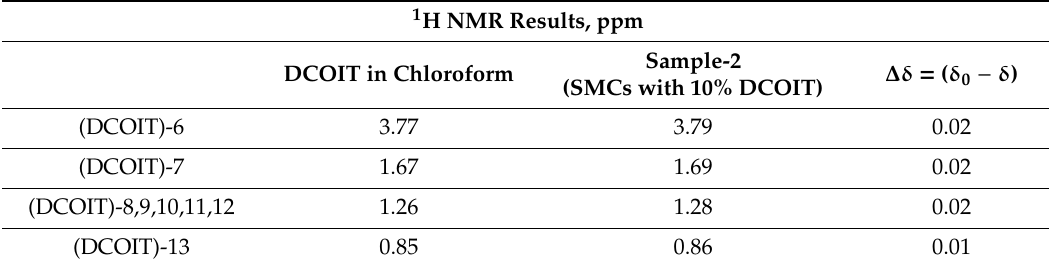
Table 2. Changes of chemical shifts 1 H NMR of DCOIT in the SMC sample with 10% DCOIT.